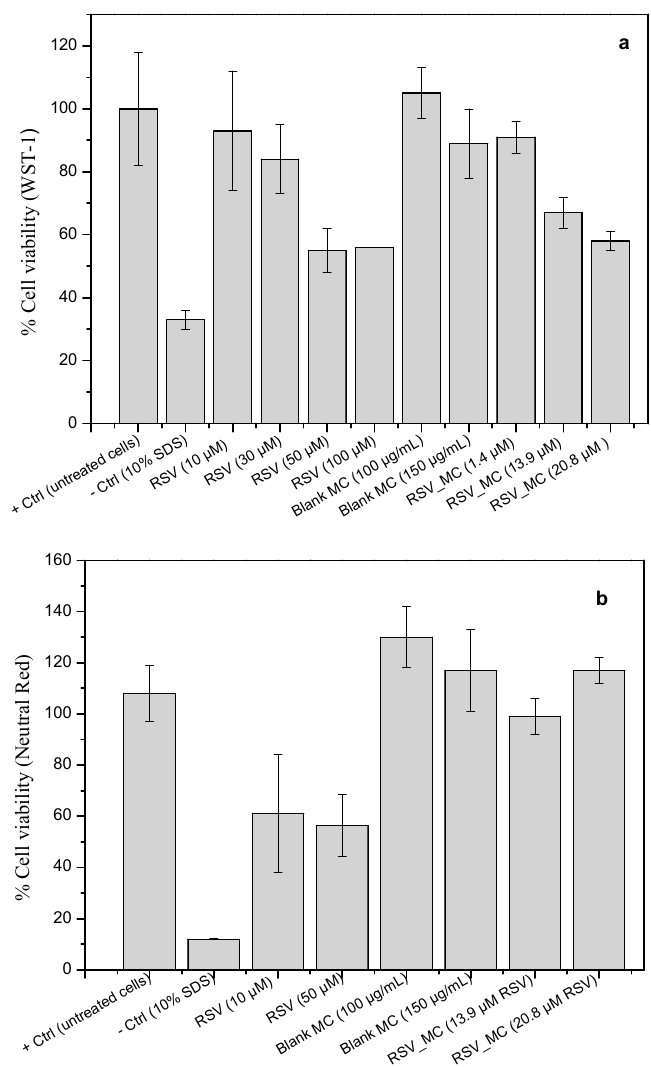
Figure 8. Percentage of macrophage viability upon incubation with free RSV, blank microcapsules, and RSV-loaded microcapsules at different concentrations. ( a ) WST-1 assay and ( b ) neutral red assay.